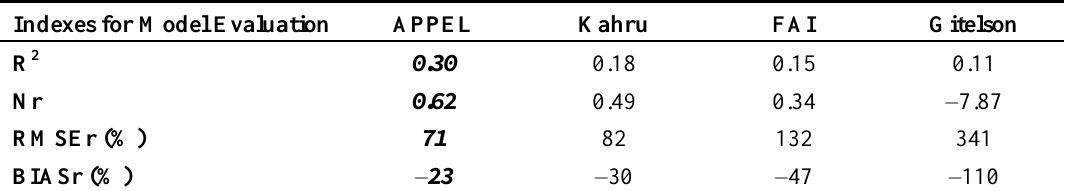
Table 4. Model performance using cross-validation results for the data subset when Chl-a is between 10 and 50 mg∙m –3 .